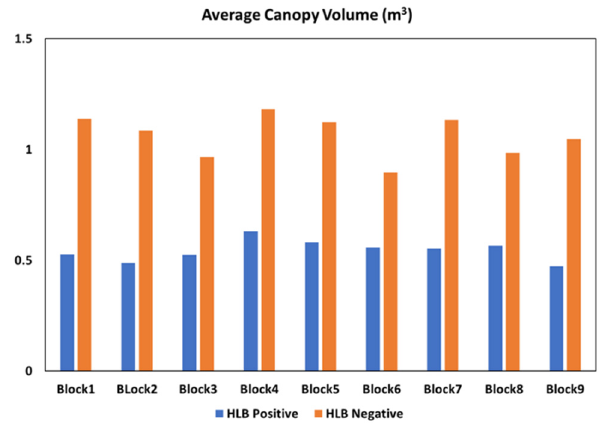
Figure 7. Ratio of ( a ) the number of trees containing leaf flushing and ( b ) the flushing area over canopy cover area between the citrus greening positive and negative trees over all blocks.